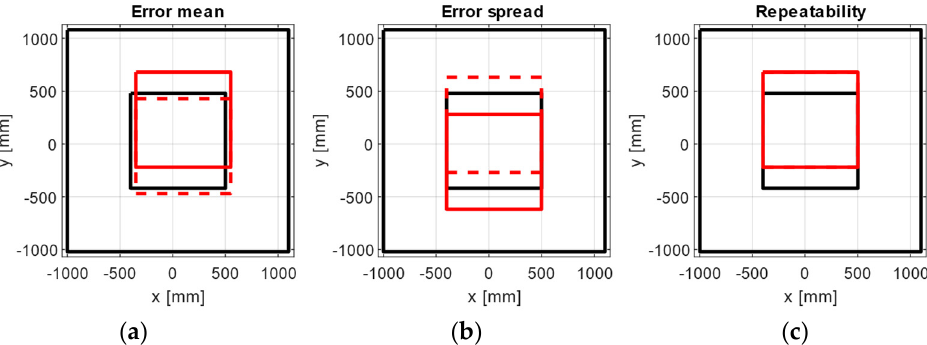
Figure 14. Inner areas with the lowest errors (red lines) for ( a ) mean error, ( b ) error spread, and ( c ) repeatability in positions (solid lines) and orientations (dashed lines). The black squares represent the inner and large areas.